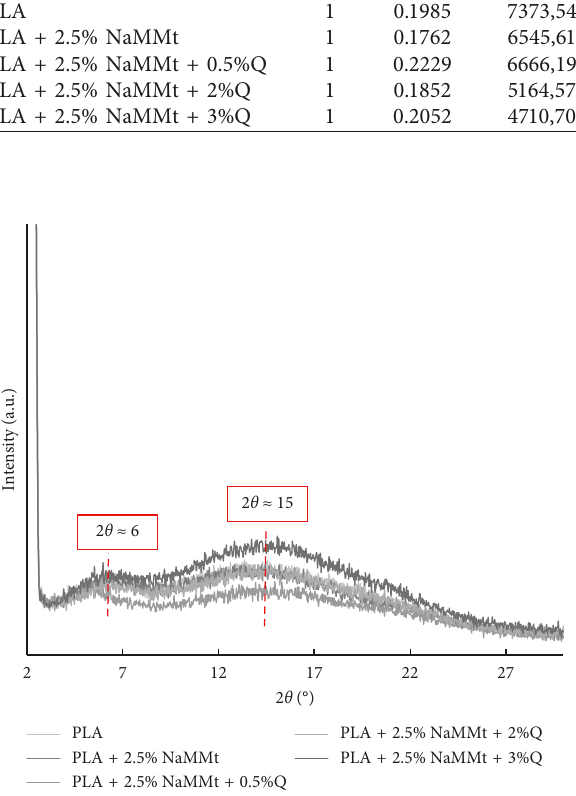
Figure 2: XRD spectra of neat PLA and PLA/NaMMt containing different amounts of Q.